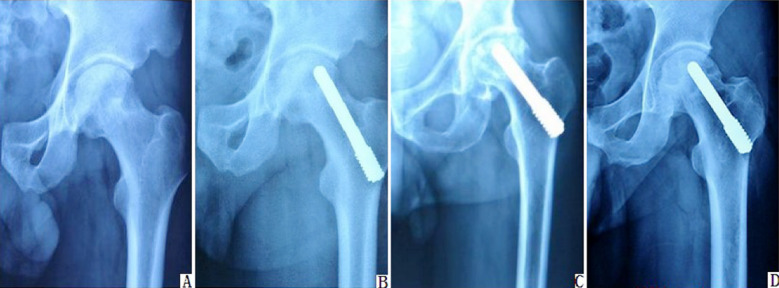
X-ray appearances for a male patient with Stage-II femoral head necrosis before and after treatment. A: Weight bearing area of femoral head exhibited cystic degeneration before surgery; B: X-ray appearance of surgical site 3 months after surgery; C: X-ray appearance of surgical site 6 months after surgery; D: X-ray appearance of surgical site 12 months after surgery.